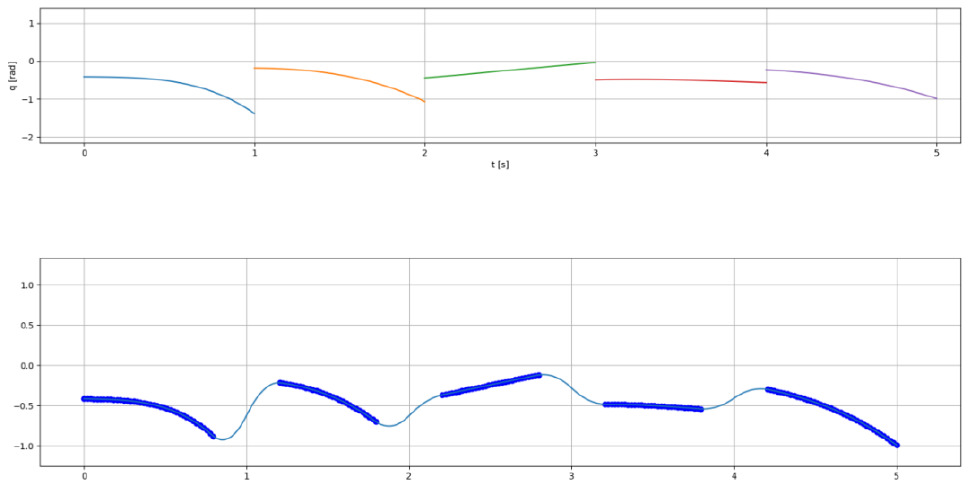
Figure 14. The illustration of the interpolation